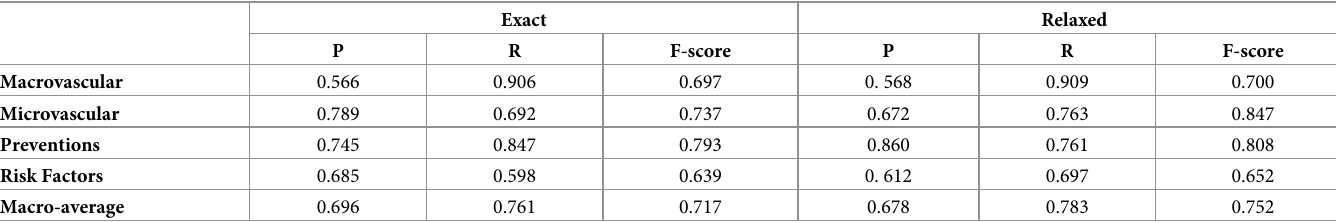
Table 4. IAA for tweets using exact and relaxed matching